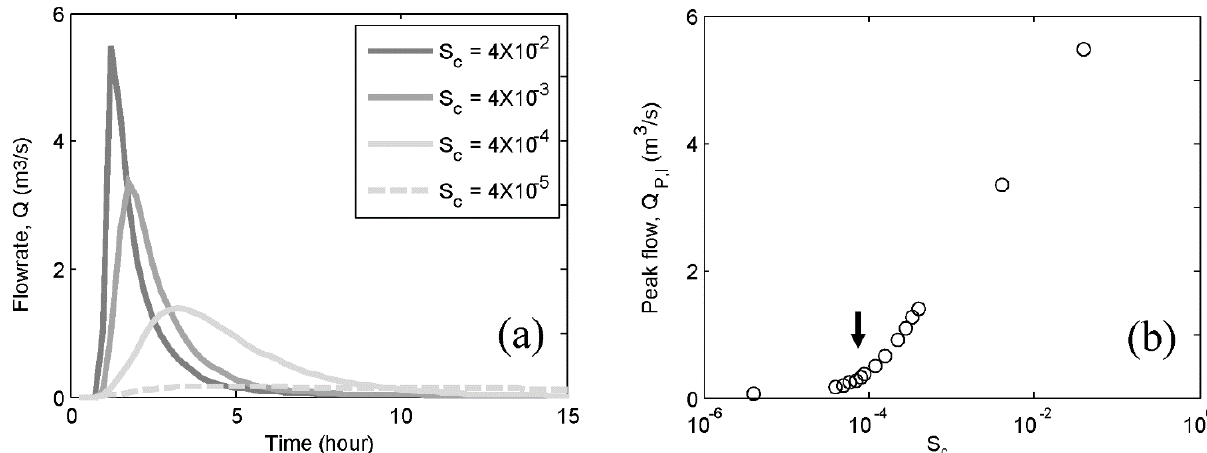
Figure 3. Behavior of a fully looped network depending on the catchment slope ( S c ):